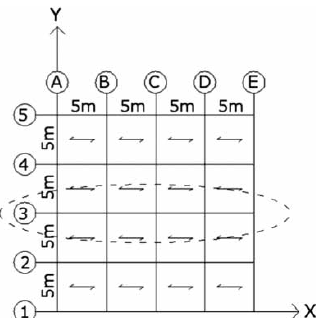
Fig. 11. Resulting forces in LSB systems due to lateral